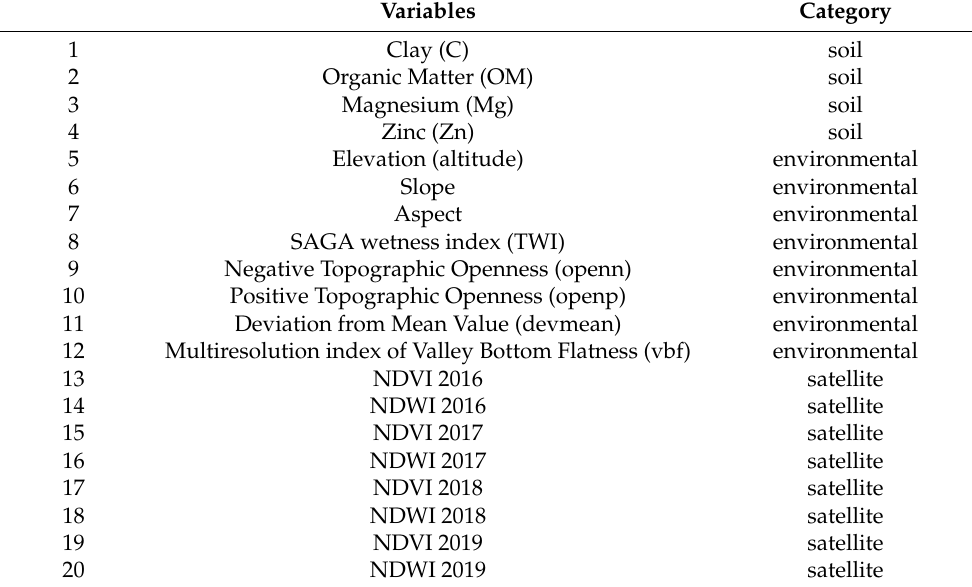
Table 1. Variables used in the